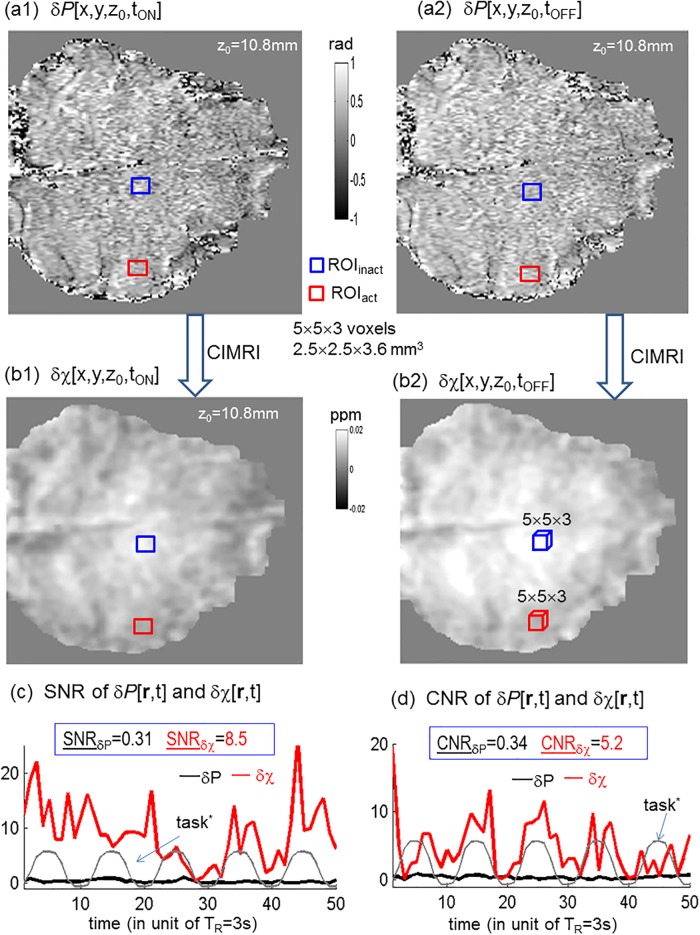
The BOLD δχ[r,t] reconstruction from δP[r,t] by CIMRI (demonstrated with a z0 slice in a volume at an ON and OFF snapshot).The SNR and CNR values were calculated according to the definition in Eq (14), with the ROIact and ROIinact defined retrospectively in Fig 5(c2), in a small size of 5 × 5 × 3 voxels. The SNR and CNR denote time averages. The task* is included to observe the dynamics of SNR and CNR with respect to the stimuli. The ON and OFF snapshots are labeled in Fig 2.